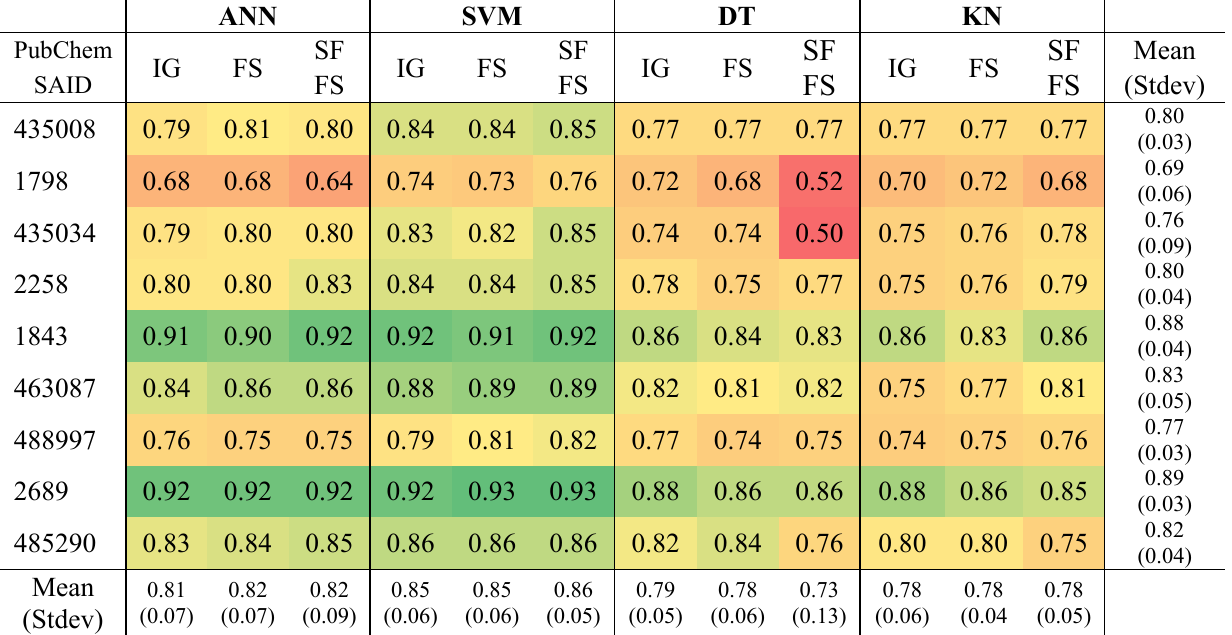
Table 2. Descriptor selection results for Information Gain (IG), F-Score (FS), and Sequential Feature Forward Selection (SFFS) applied to each ML technique paired with each PubChem HTS data set. Results for the integral of the TNR-TPR curve are presented. The mean and standard deviation for each SAID (row) and each descriptor selection approach (column) is